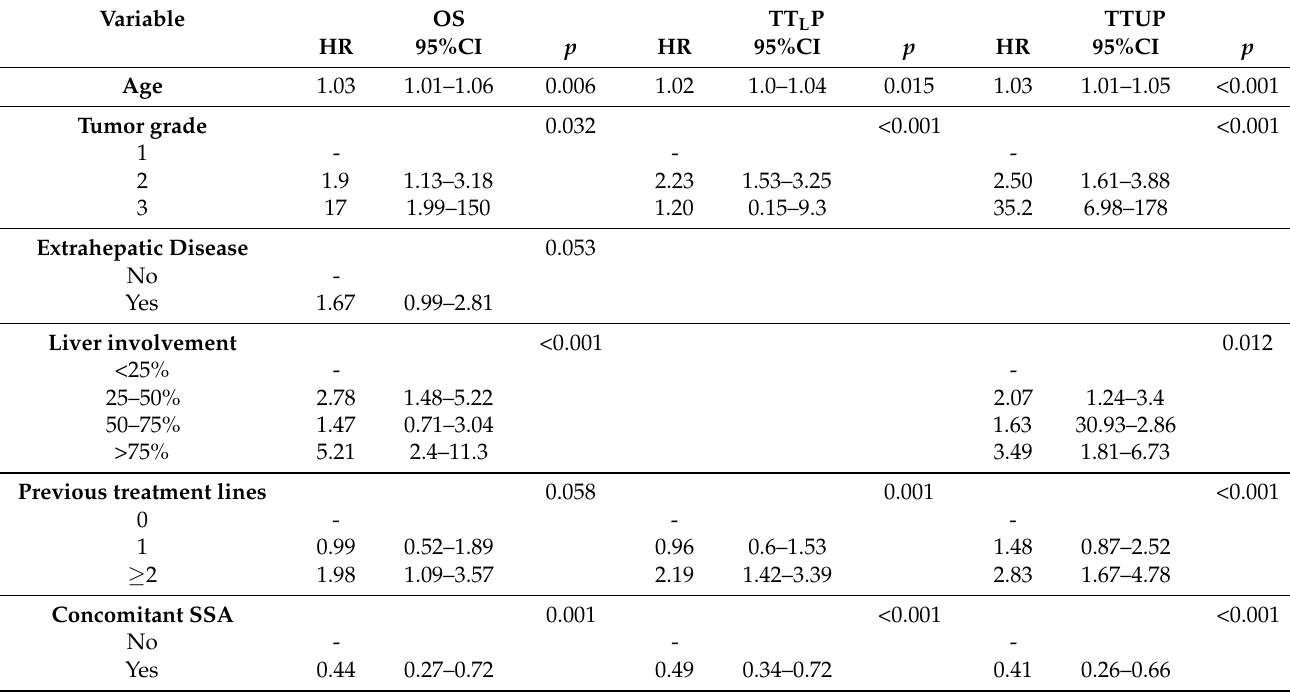
Table 6. Prognostic factors for TT L P, TTUP and OS—Multivariate